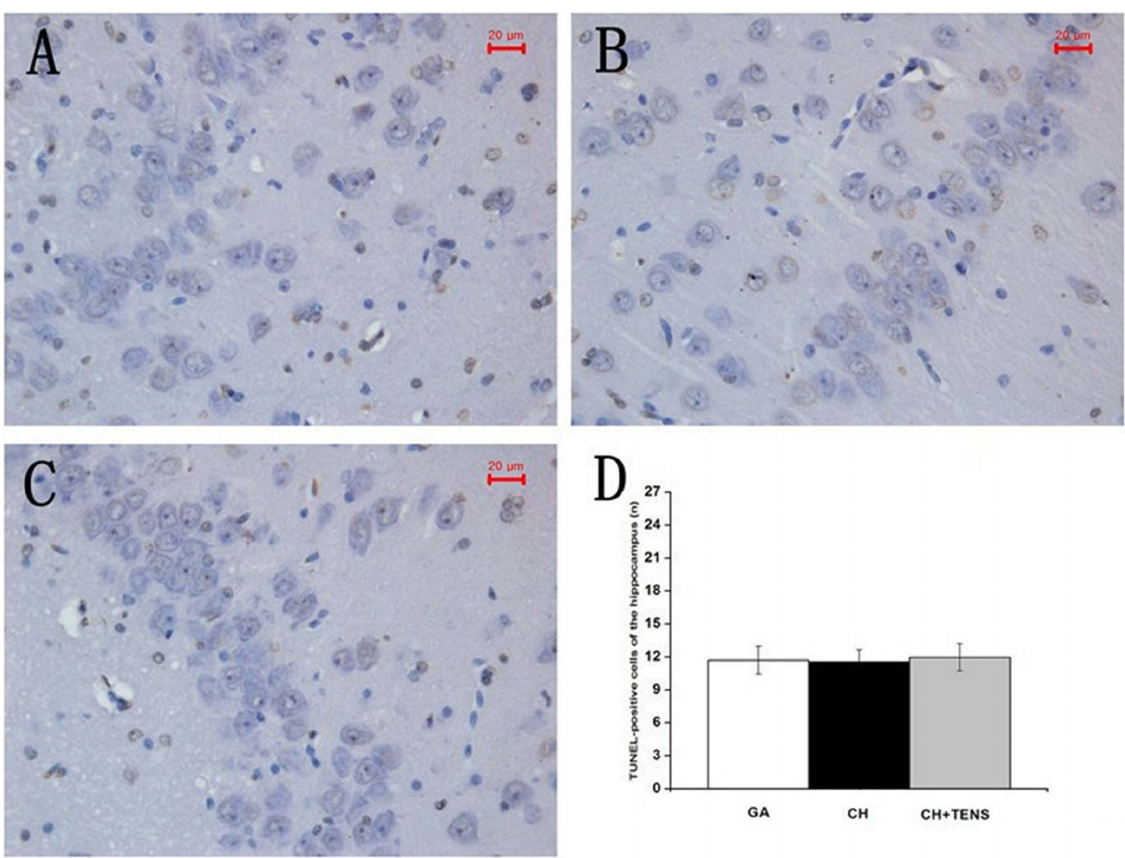
Figure 10. Terminal deoxynucleotidyl transferase-mediated dUTP-biotin nick end labeling (TUNEL) staining of canine hippocampus after controlled hypotension (CH). The number of TUNEL-positive cells was quantified at a high magnification ( 6 400). A stable number of TUNEL-positive cells were found in all three groups (A, B, C), and no significant statistical difference was noted between these groups (D). The number of TUNEL-positive cells is presented as mean 6 standard error of the mean. n=6 per group. Scale bar =20 m m.